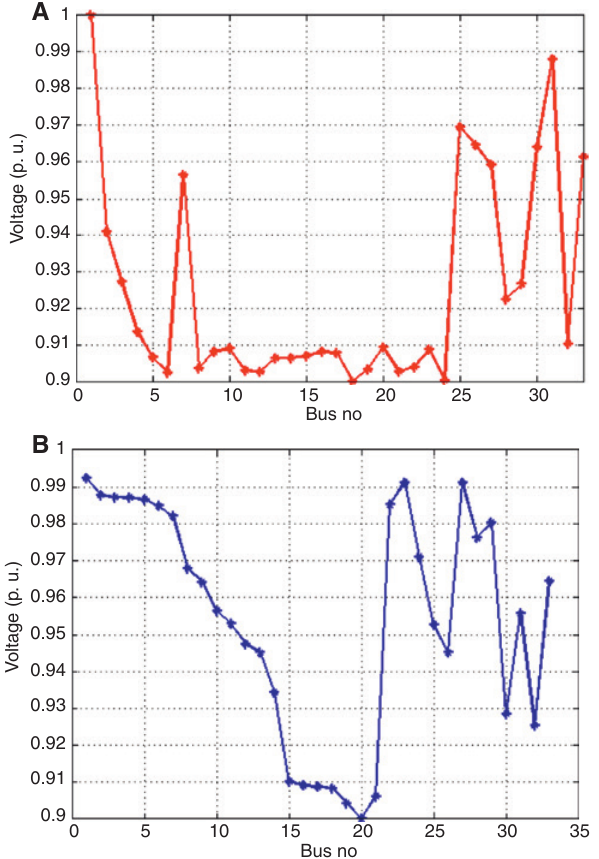
Figure 4: (A) Performance Analysis of Voltage Profile Using the BW/FW Sweep Method. (B) Performance Analysis of Voltage Profile Using the Proposed Method.